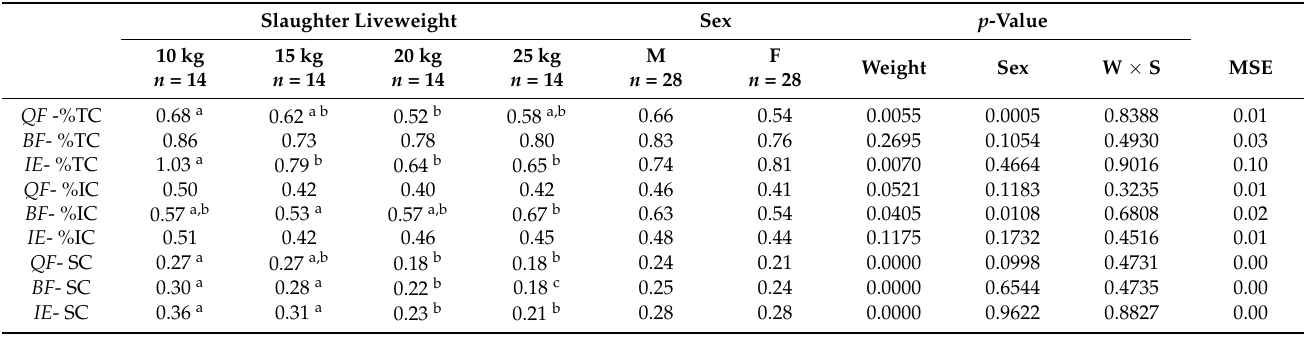
Table 5. Means and mean square errors of the percentage of total collagen, insoluble collagen and soluble collagen extracted from the QF, BF and IE muscles in the four weight groups and in male and female